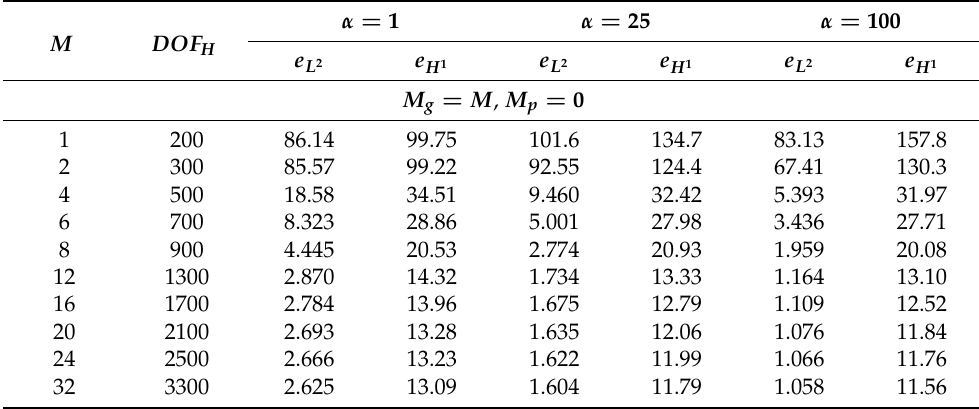
Figure A1. Parabolic problem with α = 100 for different time layers t m with m = 5,15, and 40 (from left to right ). Case 1 (homogeneous boundary conditions). Top : Reference solution ( DOF h = 85,230). Bottom : Multiscale solution with 12 multiscale basis functions, e L 2 = 2.22 for t 1 , e L 2 = 1.605 for t 10 , e L 2 = 1.058 for t 40 ( M g = M = 12, M p = 0, DOF H = 1300). Table A1. Parabolic problem with α = 1,25, and 100. Case 1 (homogeneous boundary conditions). Relative L 2 and H 1 error in %. DOF h =